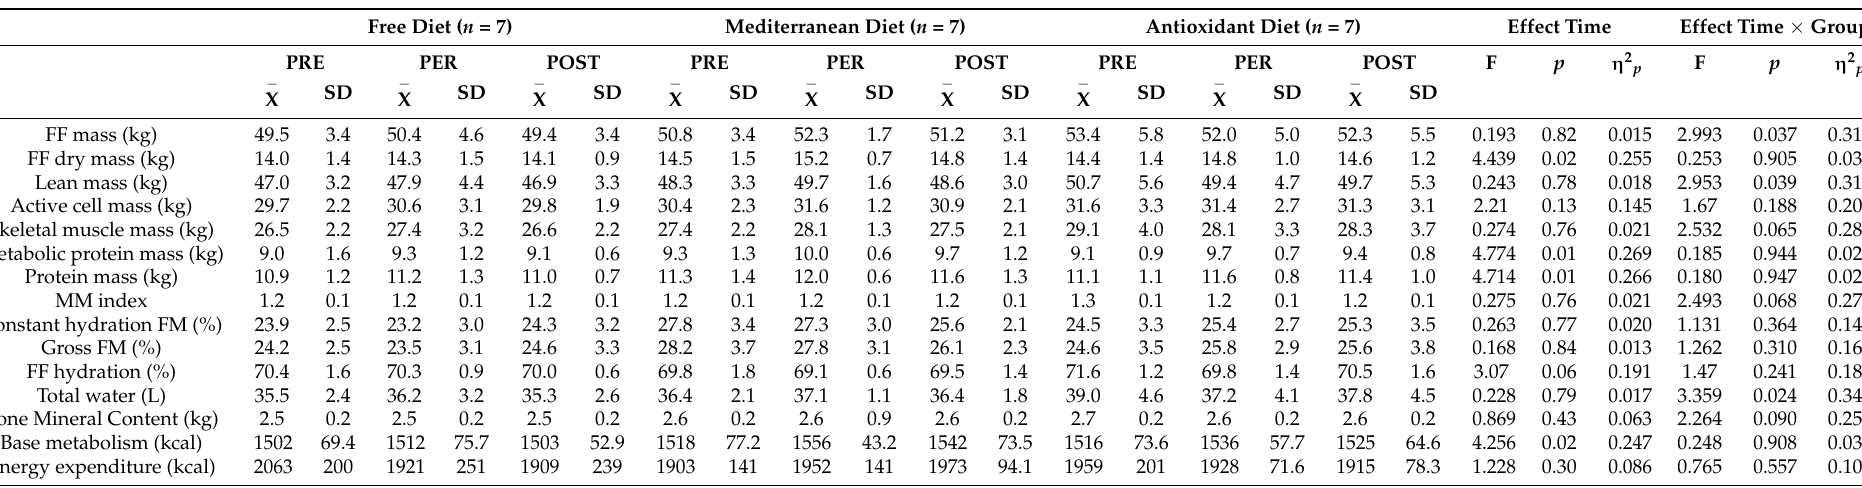
Table 6. Body composition variables measured by bioelectrical impedance at pre-, during, and post-intervention times in the free diet, Mediterranean diet, and antioxidant-rich diet groups.